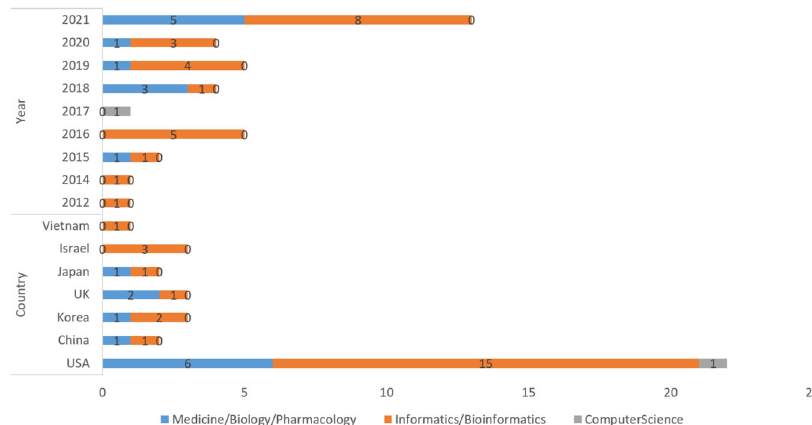
Fig. 1 Distribution of publication type, strati fi ed on the year of publication and country of origin.